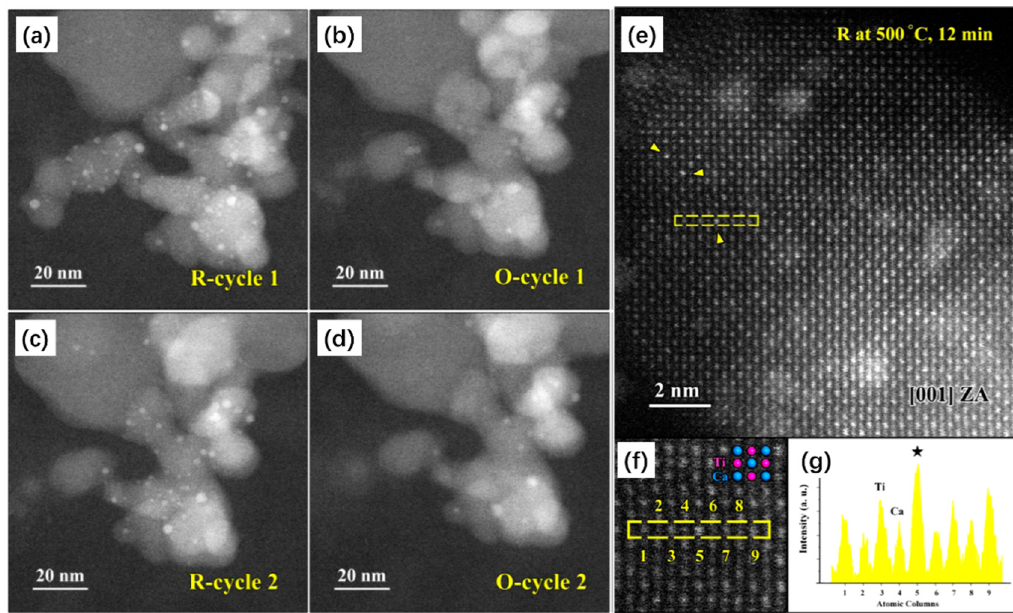
Figure 2. In situ gas-phase TEM of Rh / CaTiO 3 (Rh-CTO) in windowed gas cell. ( a – d ) HAADF images of Rh-CTO catalyst during reduction-oxidation cycles in 760 Torr of 5% H 2 / Ar (labeled by R) or pure O 2 (labeled by O) at 600 ◦ C: ( a , b ) the first reduction-oxidation cycles (labeled “1”) and ( c , d ) the second reduction-oxidation cycles (labeled “2”). ( e , f ) Atomic resolution in situ HAADF image of Rh-CTO catalyst in reduction atmosphere (labeled R) after 12 min at 500 ◦ C: ( e ) HAADF image taken along the [001] pseudocubic direction of one of CTO particles. The large field view shows the di ff use subnanometer bright regions without discernible structure and occasional bright spots (marked by yellow arrows) ( f ) enlarged image, containing the dashed yellow rectangular box in ( e ). The atomic site of Ca (blue) and Ti (magenta) can be distinguished by di ff erent intensity of Z contrast. ( g ) Intensity along a line scanned from left to right with the rectangular box in panel ( f ). Reproduced with the permission from [43], ACS Publishing Group, 2017.